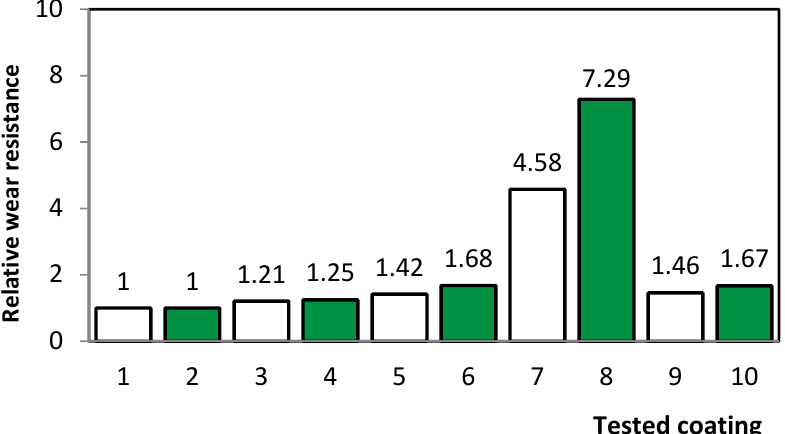
Figure 11. Diagram of the influence of the heat treatment of the substrate on the wear resistance of the tested coatings.